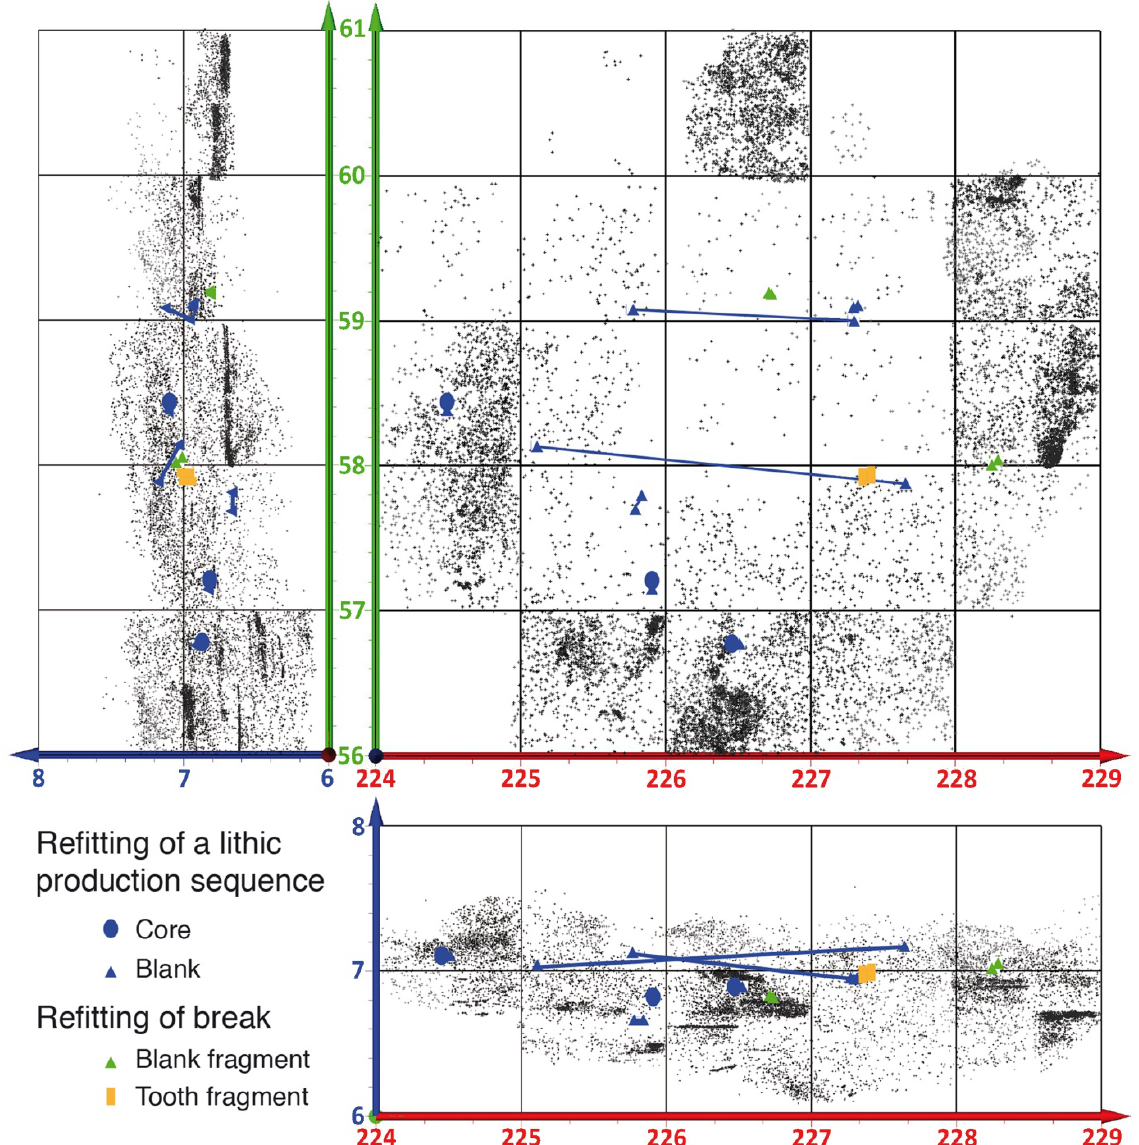
Figure 4. Refits of objects from GH 3. (Compilation by J.A. Frick and S. P.